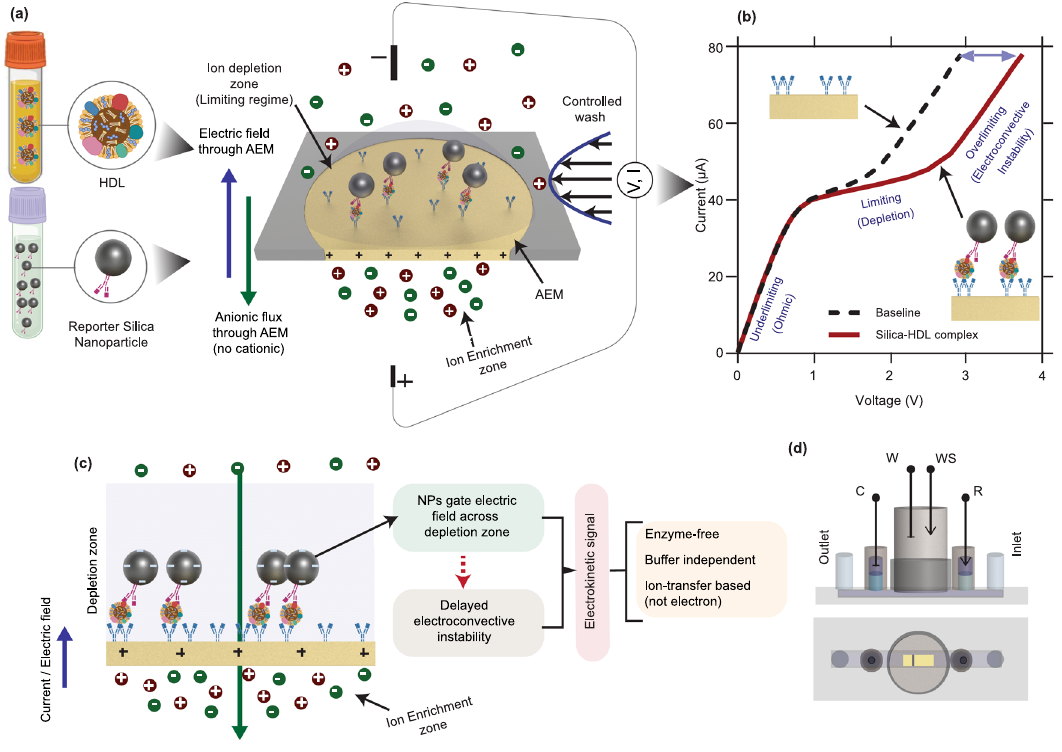
Fig. 1 | Schematic showing the overview of the Nanoparticle-gated Electro- kinetic Membrane Sensor (NGEMS) platform. a The positively charged anion exchange membrane (AEM) only allows anions to pass, with capture antibodies covalently linked to its surface. A current/electric fi eld is applied across the mem- brane such that ion depletion zone is formed over the capture surface in the lim- iting regime. The controlled wash removes non-speci fi cally bound species. A portion of a was created with biorender.com. b A general CVC curve showing the shift after addition of sample and silica reporters that allows target quanti fi cation. c Mechanism for the electrokinetic signal produced in the NGEMS platform. The charged nanoparticles gatethe electric fi eldacross the depletion layer leading to a delayed electroconvective instability. This delay shows up as voltage difference in the overlimiting regime of CVC curve. Due to the signal being of electrokinetic nature, it is not affected by HDL-associated peroxides/antioxidants that would generallyaffectenzymaticimmunoassays.Additionally,thedepletionzoneensures